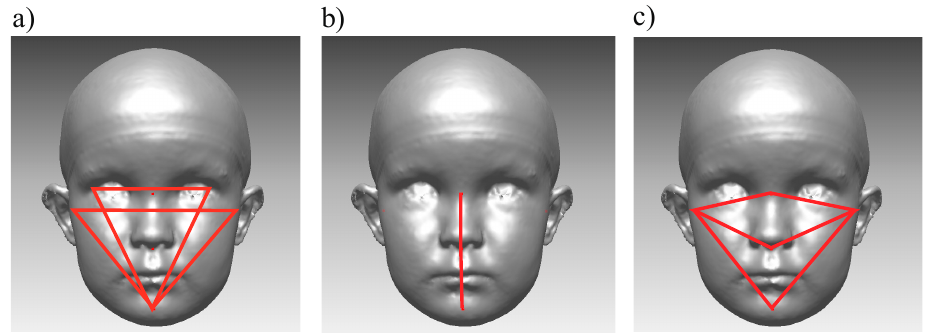
Figure 4. Landmark-based facial symmetry parameters. ( a ) Angles ExR-ExL-Pg, ExL-ExR-Pg, TrR- Figure4. Landmark-basedfacialsymmetryparameters. ( a )AnglesExR-ExL-Pg,ExL-ExR-Pg,TrR-TrL-Pg, TrL-Pg, and TrL-TrR-pg; ( b ) Angle N-Sn-Pg; and ( c ) TrNa, TrSn, and TrPg lines. and TrL-TrR-pg; ( b ) Angle N-Sn-Pg; and ( c ) TrNa, TrSn, and TrPg